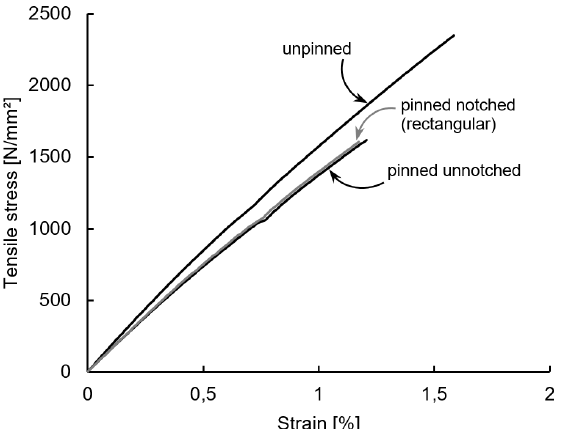
Figure 5. Representative load-displacement curves for tensile tests of unpinned unidirectional laminates as well as z-pin reinforced laminates with unnotched pins and notched pins with rectangular notch design with a notch depth of 20 µ m and notch distance of 100 µ m.